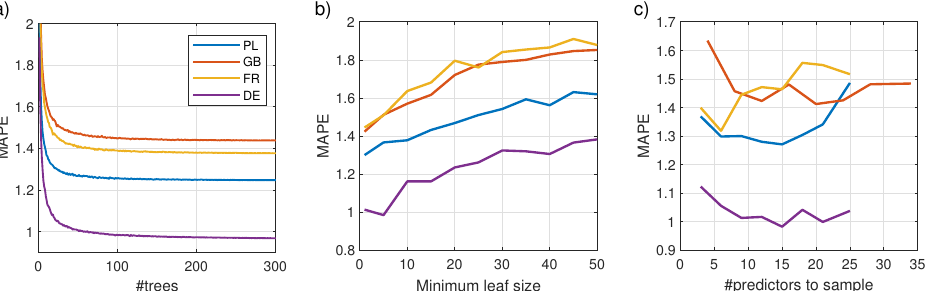
Figure 7. Validation MAPE depending on hyperparameters: number of trees in the forest ( a ), minimum number of leaf node observations ( b ) and number of predictors to select at random for each decision split ( c ).